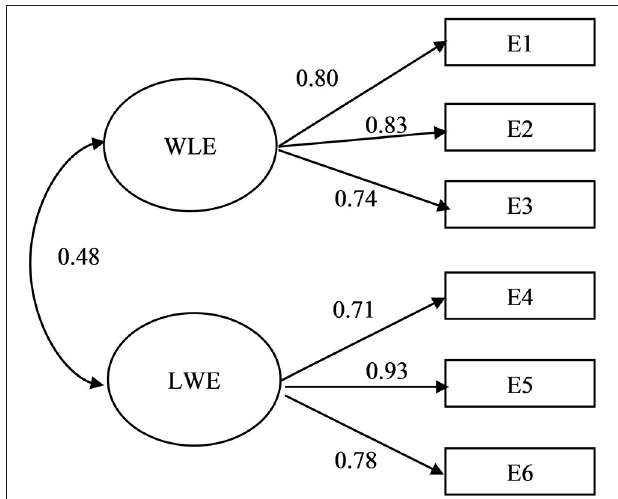
FIGURE 1 | Factor loading/correlations for a two-factor model of enrichment for men.